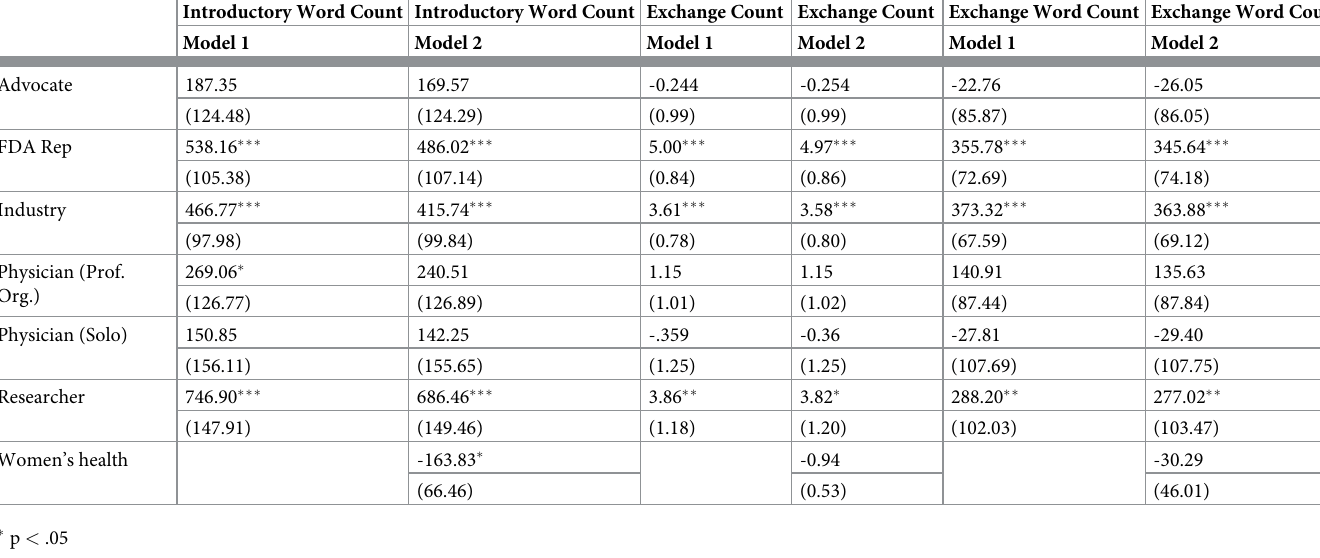
Table 3. Regression estimates of introductory word count, exchange count, and exchange word count (N = 789). Introductory Word Count Introductory Word Count Exchange Count Exchange Count Exchange Word Count Exchange Word